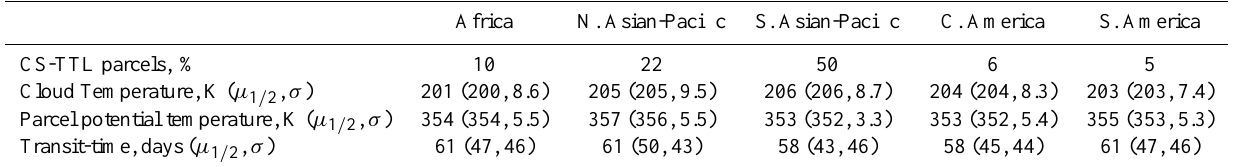
Table 2. Same as Table 1 but this time the focus is on the regional mean characteristics of convective sources and transport times.